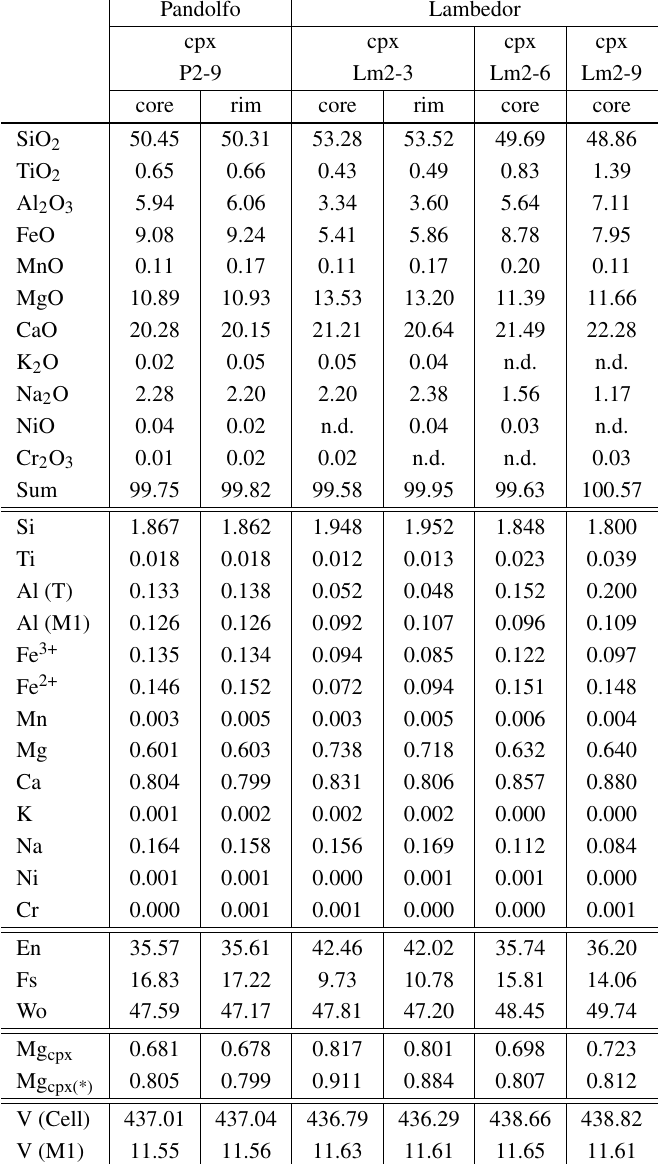
Representative electron microprobe analyses of Group III clinopyroxenes. Other informations as in Table